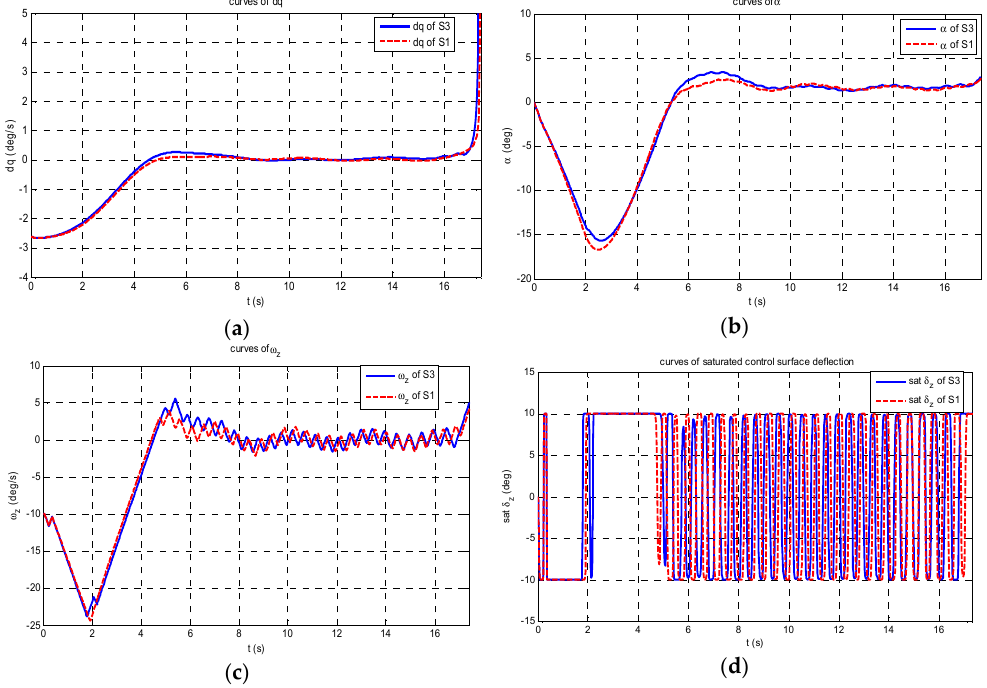
α ω . , ( c ) curves of z , and q , ( b ) curves of α , ( c ) curves of ω z , and ( d )